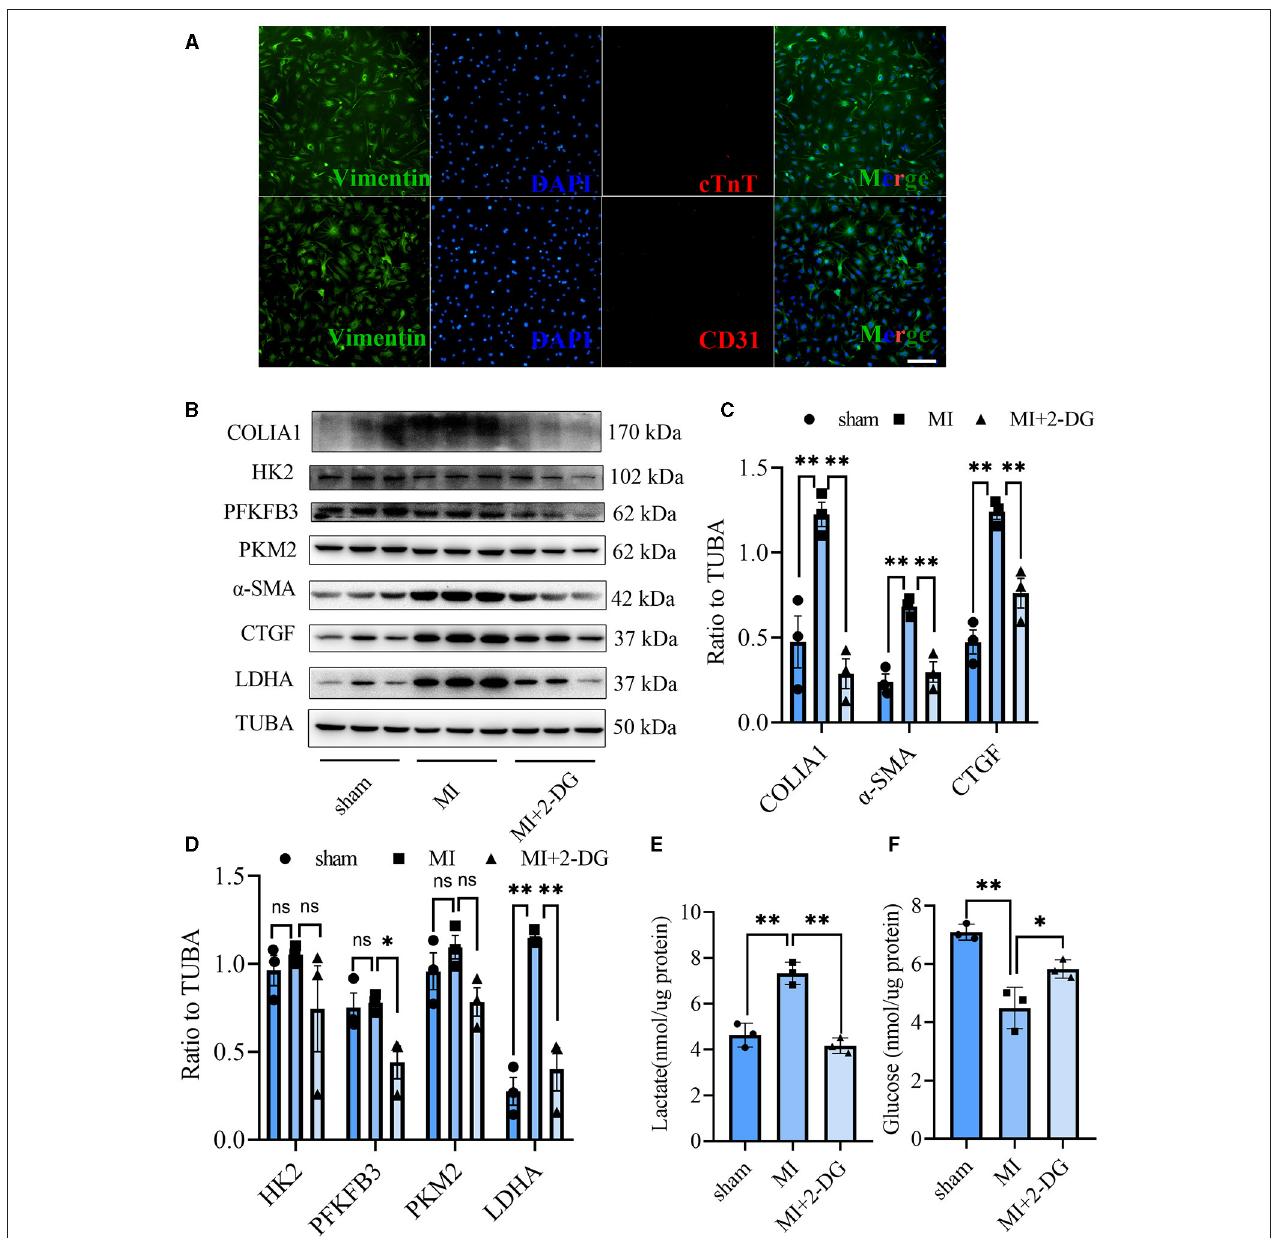
FIGURE 3 | Glycolysis inhibition could reverse the fibroblasts activation in vivo . (A) Cell identification of CF isolated from the adult mice. Green represented Vimentin. Red represented cTnT or CD31. Blue represented DAPI. (B) Western blot of the expressions of glycolytic and CF activation markers from cells isolated from the sham, MI and MI with 2-DG treatment mice. (C,D) Gray value statistics of the western blot of (B) . (E,F) Lactate (E) and glucose measurement (F) in the culture medium from cells isolated from the sham, MI and MI with 2-DG treatment mice. COLIA1, type I collagen; α -SMA, alpha smooth muscle actin; CTGF, connective tissue growth factor; PFKFB3, 6-phosphofructo-2-kinase/fructose-2, 6-bisphosphatase 3; PKM2, pyruvate kinase isoform M2; HK2, hexokinase 2; TUBA, α -tubulin; LDHA, lactic dehydrogenase A; cTnT, troponin T; n = 3, each sample was composed of CFs from two mice hearts; * P < 0.05; ** P < 0.01; ns, no significance. Scale bar = 100 µ m.